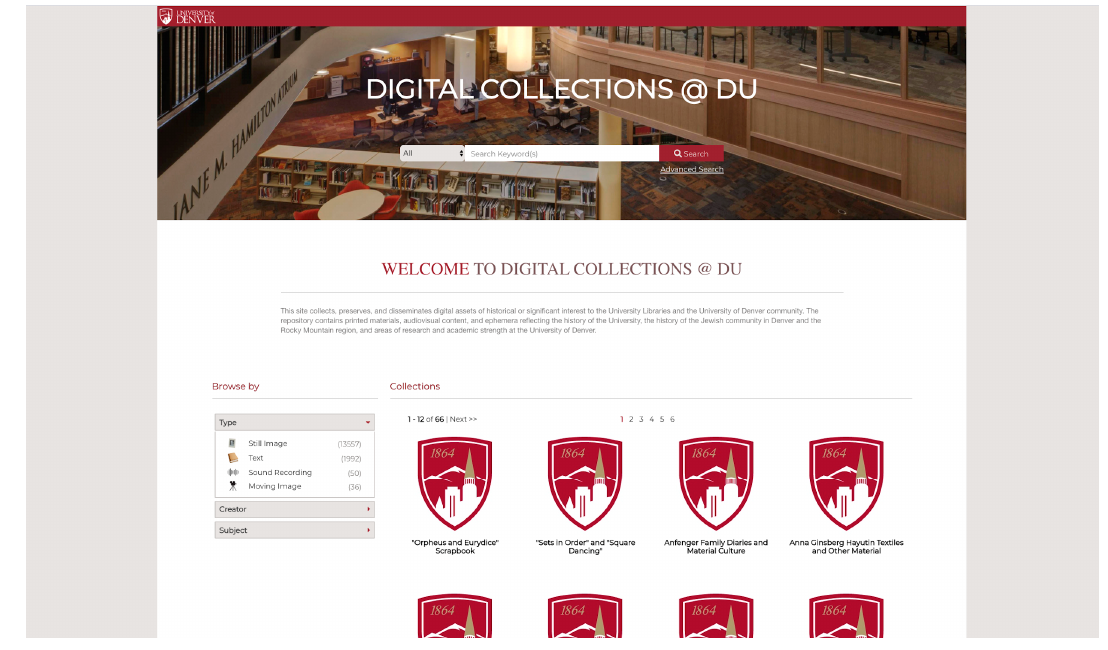
Figure A1. digitaldu—frontend repository screenshots (Landing page).